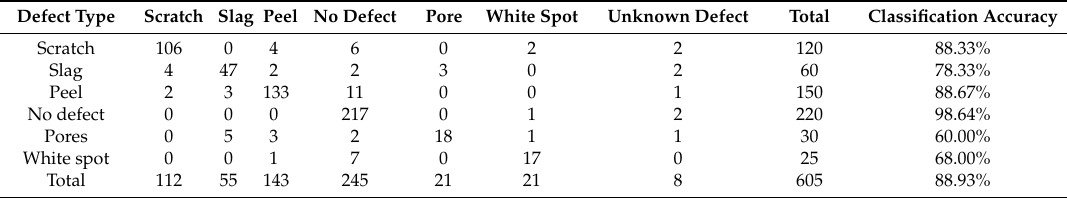
Table 12. Confusion matrix obtained using the retrained ELM with new samples of “white